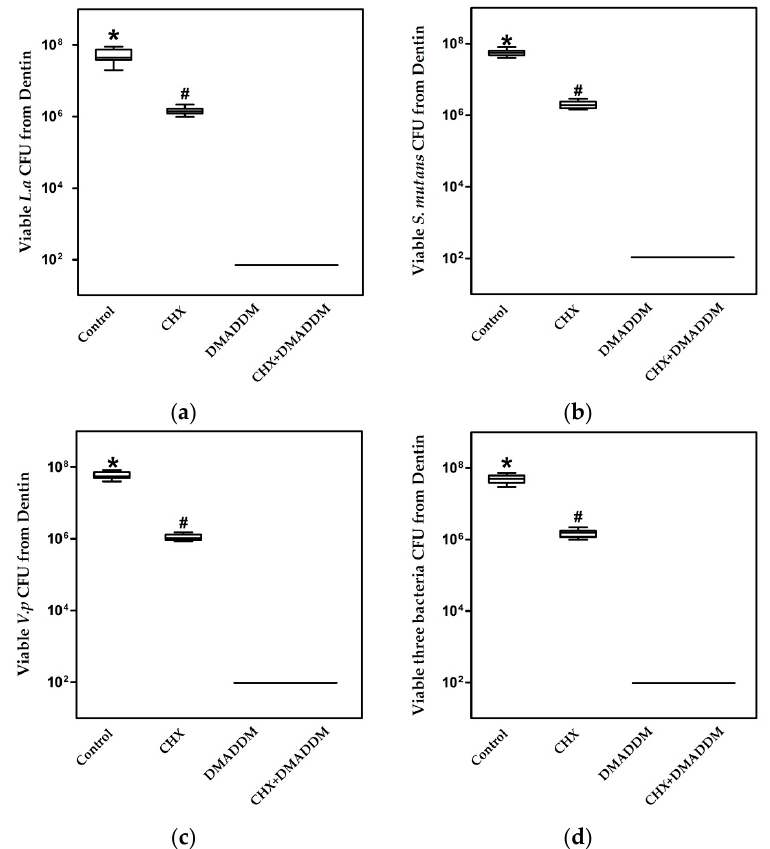
Figure 4. Colony-forming units (CFU ) of bacteria in dentin blocks harvested by sonication ( n = 10): ( a ) Lactobacillus acidophilus ; ( b ) S. mutans ; ( c ) Veillonella parvula ; ( d ) Mixture of three bacteria. The asterisk represents statistically significant differences; * p < 0.05.